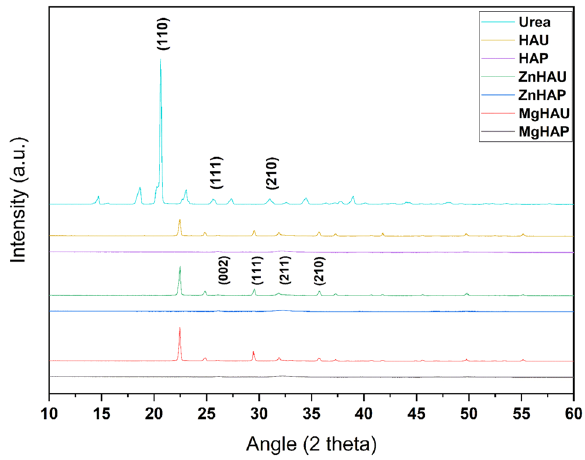
Figure 1. Powder X-ray diffraction (PXRD) analysis of the synthesized nanohybrids (HAU, MgHAU, and ZnHAU), bare nanoparticles (HAP, MgHAP, and ZnHAP), and